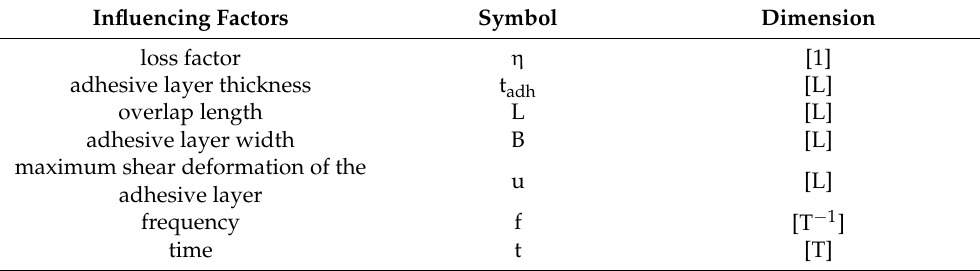
Figure 13. Evaluation of the influence of the overlap length on the loss factor of the overlap joint configurations 1, 2 and 3 with overlap lengths 20 and 60 mm depending on the adhesive used; representation normalised to the loss factor of the test specimens with overlap length 20 mm for the adhesives EPH and PUR based on [22]. Table 3. Influencing factors for characterising the damping properties of bonded overlap joints based on [22].